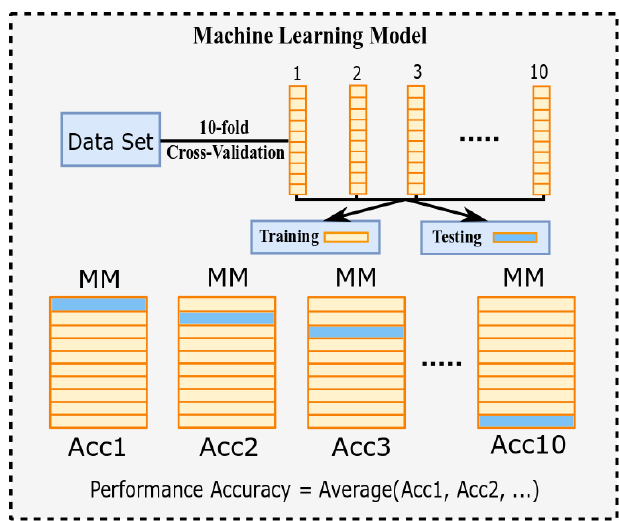
Figure 3. Machine learning model with 10 fold